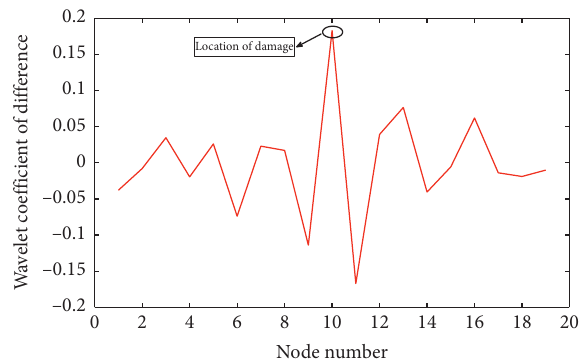
Figure 23: Wavelet coefficient difference for 5% damage in section